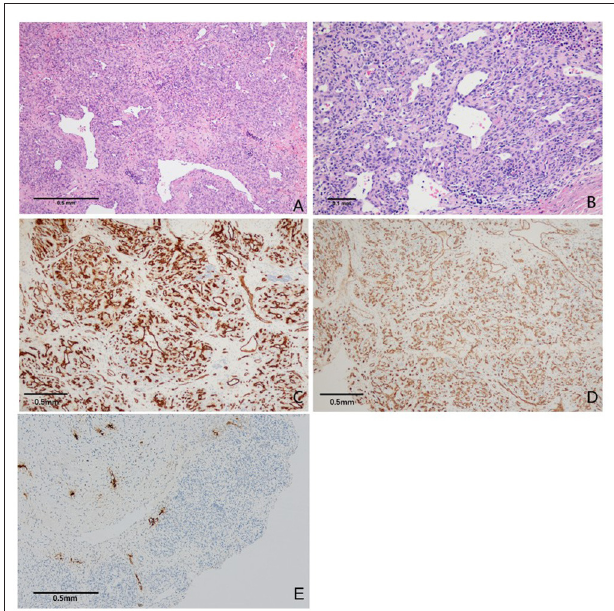
FIGURE 3 | Photomicrographs of tumor tissue. (A) Tumor cells were diffusely distributed, partly showed lobulated shape with mild collagenization of the stroma, a few staghorn-like vascular channels were observed (H&E, original magnification × 100). (B) Tumor cells are smaller in size, lack atypia. The neoplastic cells were focally arranged in a fascicular pattern in the context of infiltration of lymphocytes and histiocytes (H&E, original magnification × 200). (C,D) The tumor cells were strongly positive for CD31 and CD34. Vascular endothelial cell proliferation was observed (immunoperoxidase × 200). (E) Immunohistochemical staining for D2-40 expression was positive (immunoperoxidase ×